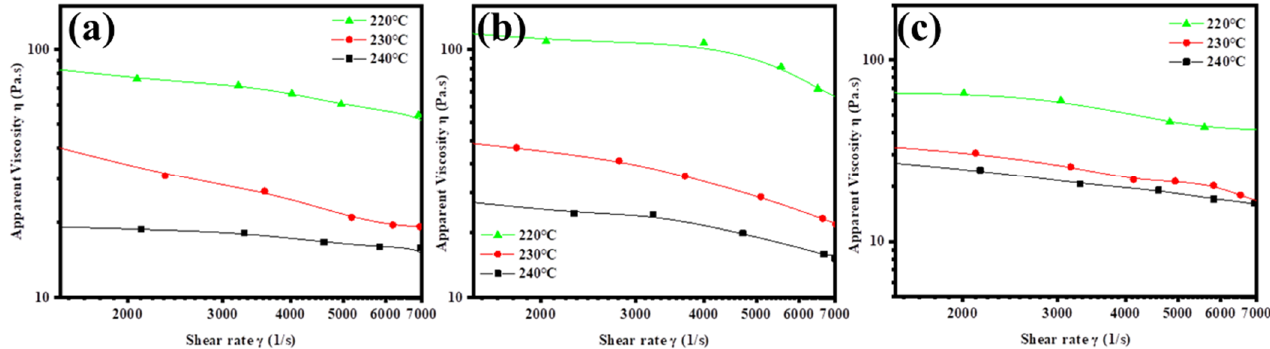
Figure 8. Apparent viscosity plots of blended samples for ( a ) PBHA-C5/PBT = 33/67, ( b ) PBHA- C5/PBT = 30/70, and ( c ) PBHA-C5/PBT = 27/73 under different temperatures and shear rates.